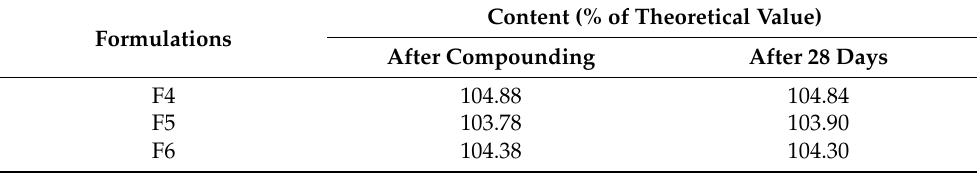
Table 7. Results of assay testing after compounding and after 28